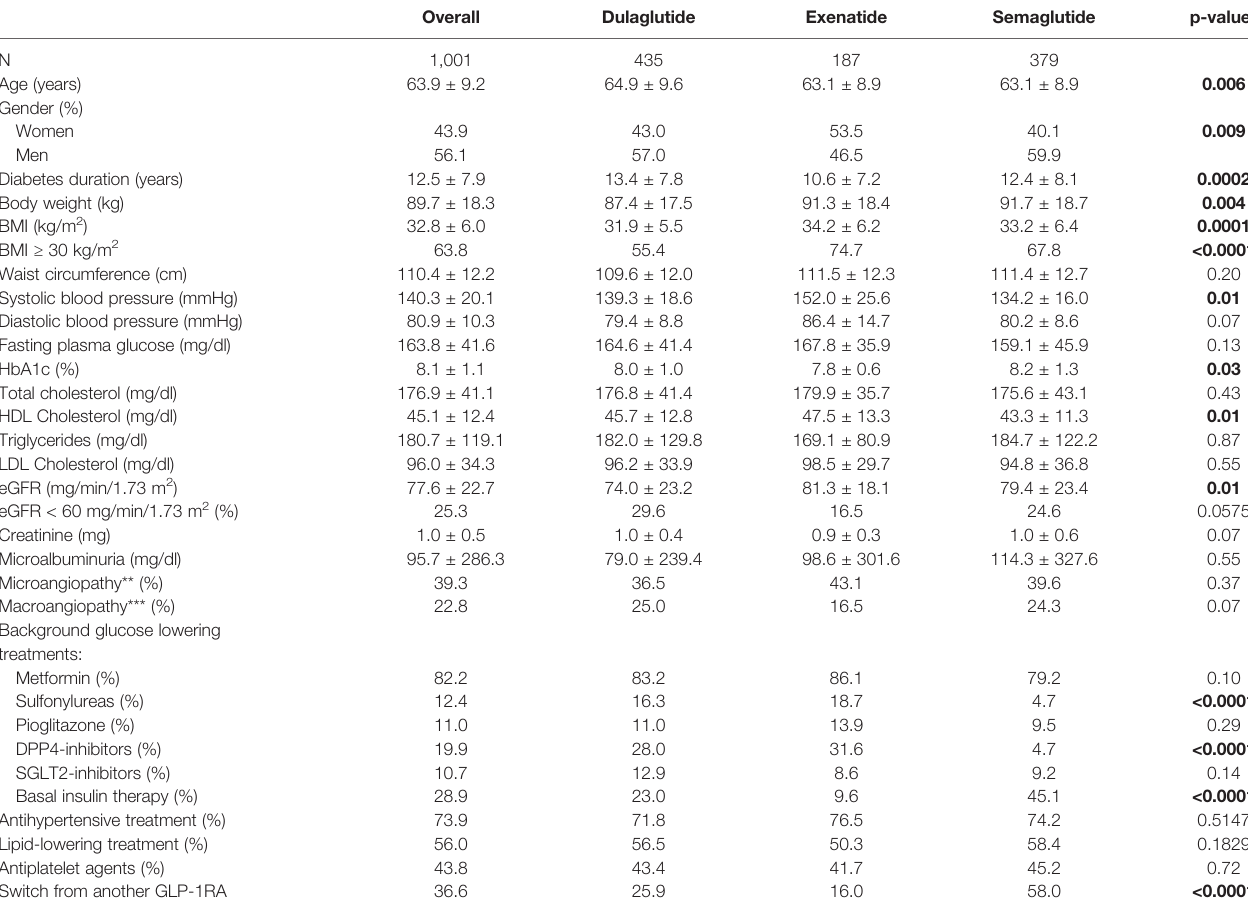
TABLE 1 | Baseline patients characteristics overall and by